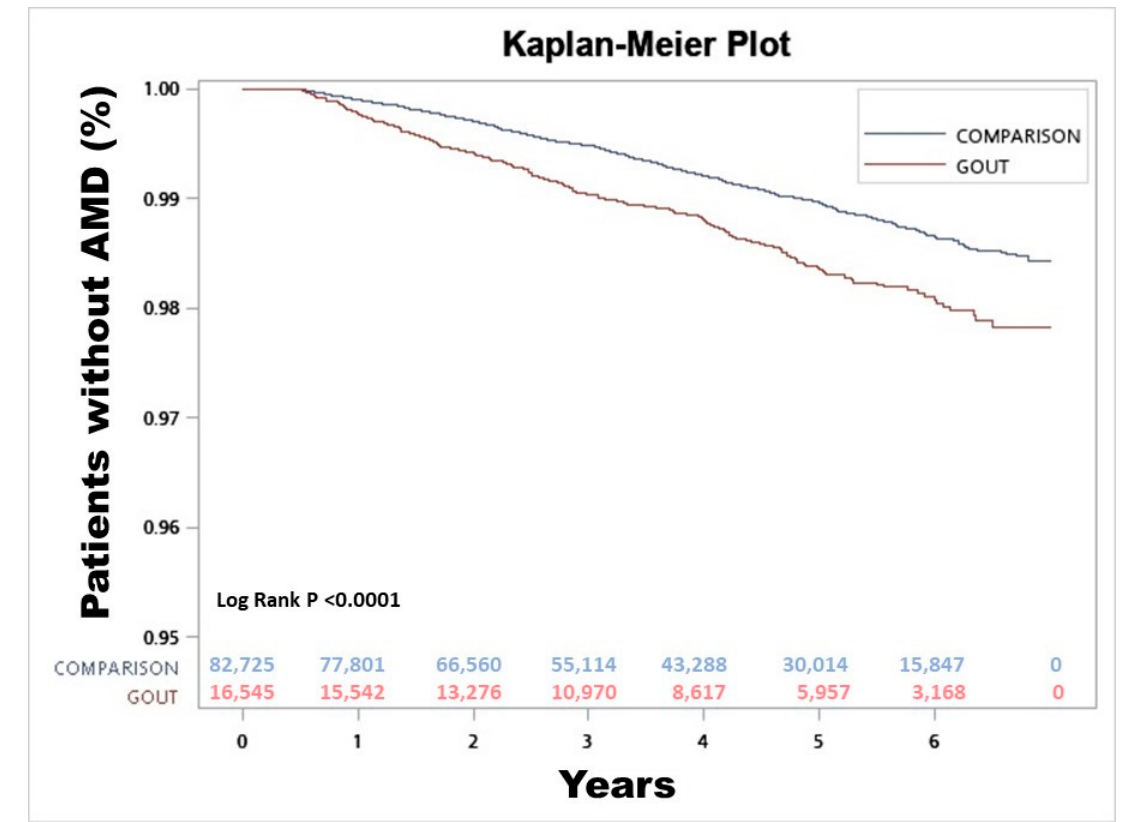
Figure 1. Kaplan–Meier plot comparing the development of age-related macular degeneration between gout patients and comparison group.